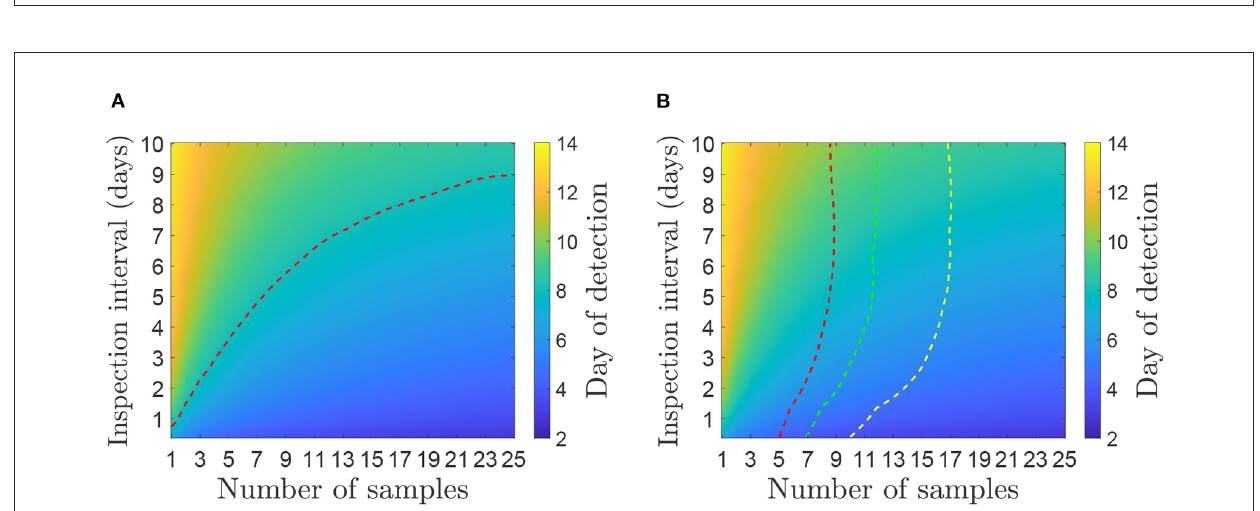
FIGURE3 Mean day an outbreak would be first detected under different environmental sampling strategies for a herd size of 50 cattle. (A) Comparison with the mean time of detection (8.07 days) estimated for the 2001 UK epidemic (19). (B) Comparison with inspection for clinical signs assuming animals are inspected at the same frequency as environmental samples are taken (given on the y-axis). The red dotted line (left) shows day of detection when 5% of the herd are inspected, green line (middle) is 10% and yellow line (right) is 20%. A strategy below or to the right of the dotted line has a lower mean day of detection and therefore performs better than the corresponding level of clinical surveillance.